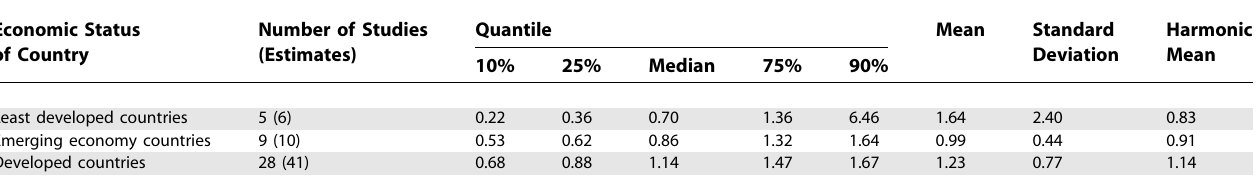
Table 12. Quantiles and Moments of Male:Female Prevalence Estimate Ratio by Economic Status of Country Economic Status of Country